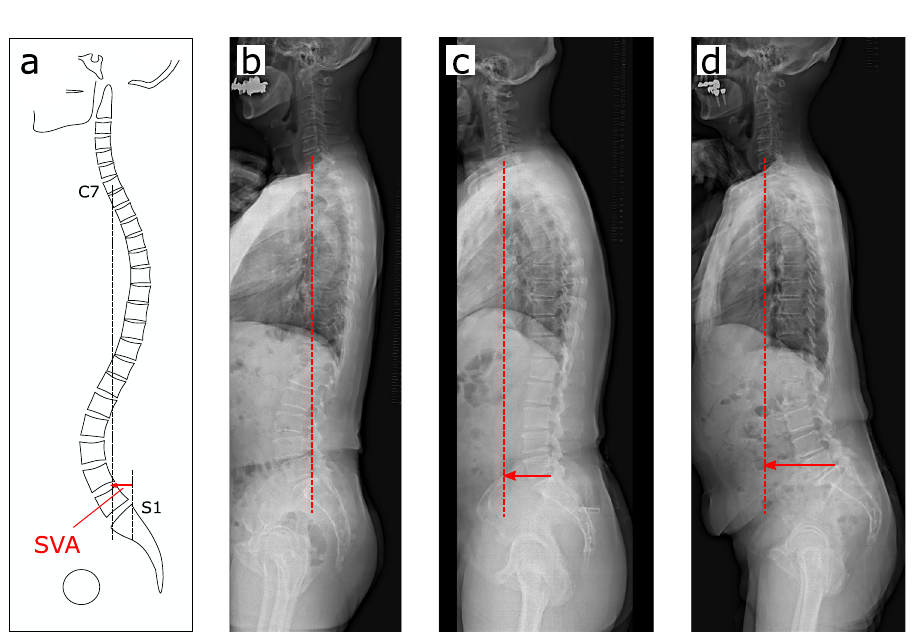
Figure 3. Sagittal vertical axis as a radiological parameter representing sagittal spinal balance. ( a ) SVA is the distance from the plumb line from the center of C7 to the posterior edge of the upper sacral endplate surface; ( b ) SVA = 0 mm, which is in sagittal balance; ( c ) SVA = 70 mm, which represents sagittal balance anteriorization; ( d ) SVA = 95 mm, which is highly anteriorized and indicates sagittal imbalance. SVA sagittal vertical